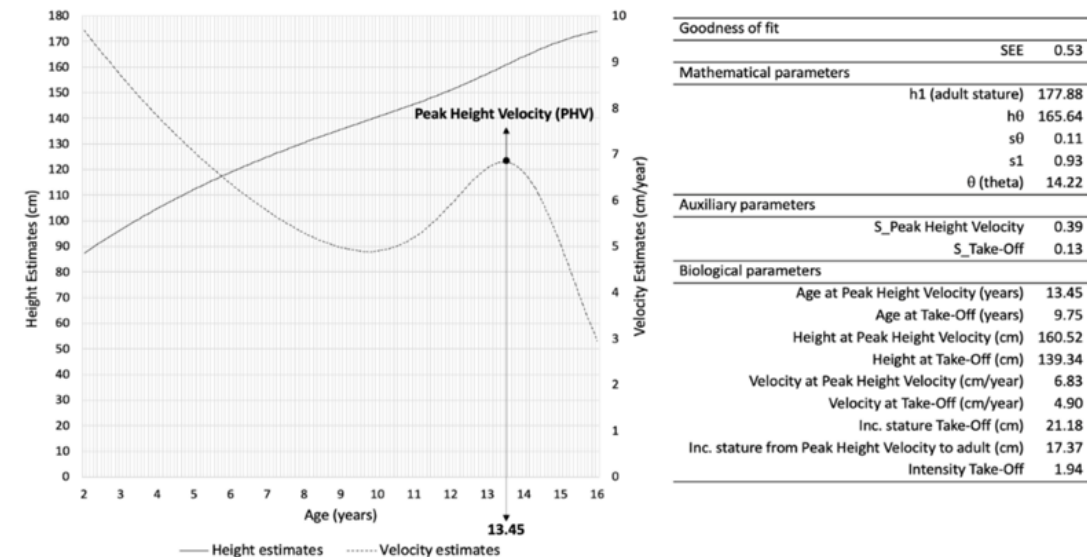
Figure 2. Smooth distance curve (height estimates), velocity curve (first derivate of the fitted function) indicating age at peak height velocity (APHV), and parameter estimates according to Preece-Baines model I.